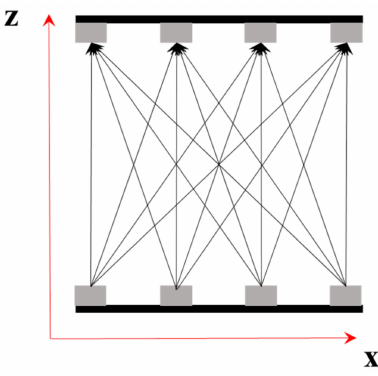
Figure 3. Virtual lines representing current between electrodes on opposite arrays. Resistance measurements between all pairs of electrodes are used for volumetric reconstruction of soil moisture